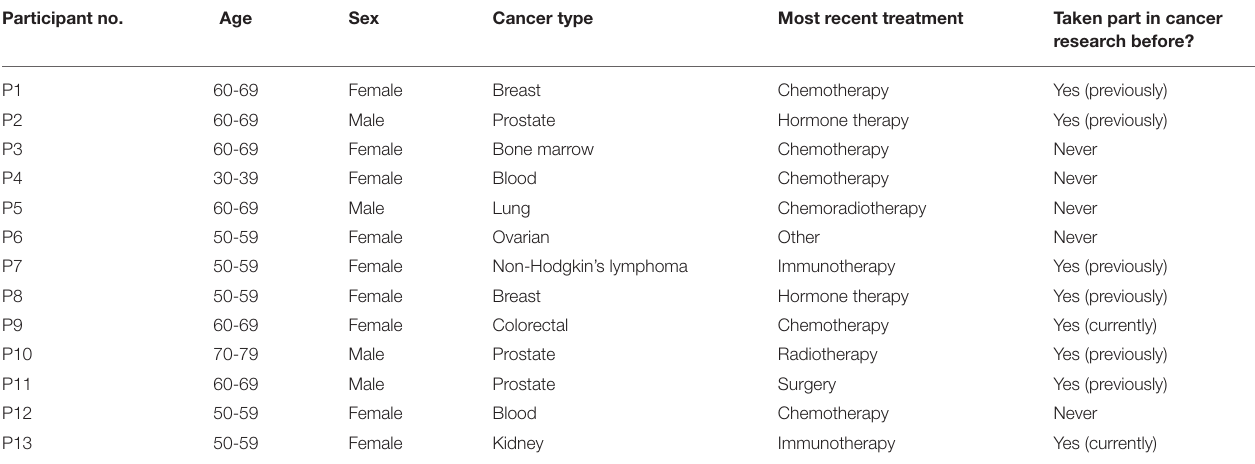
TABLE 1 | Characteristics of interviewees. Participant